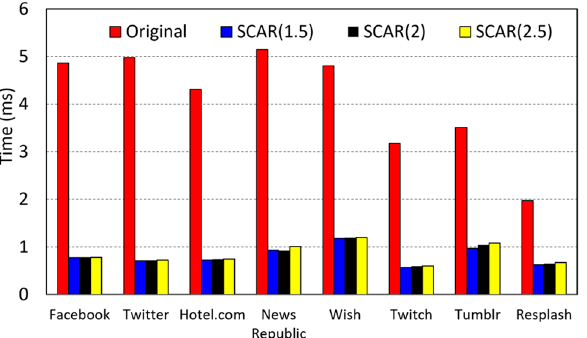
Figure 15. Overall execution time of the method draw() in a frame rendering operation.